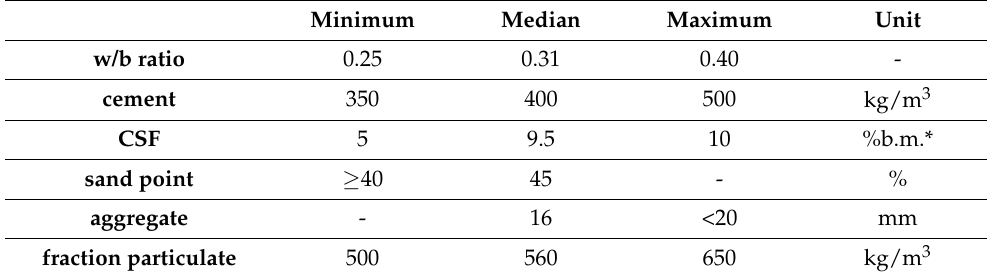
Table 4. Component ranges for composition of HPSCC based on the analysis of literature (analysis of seventy-six compositions)